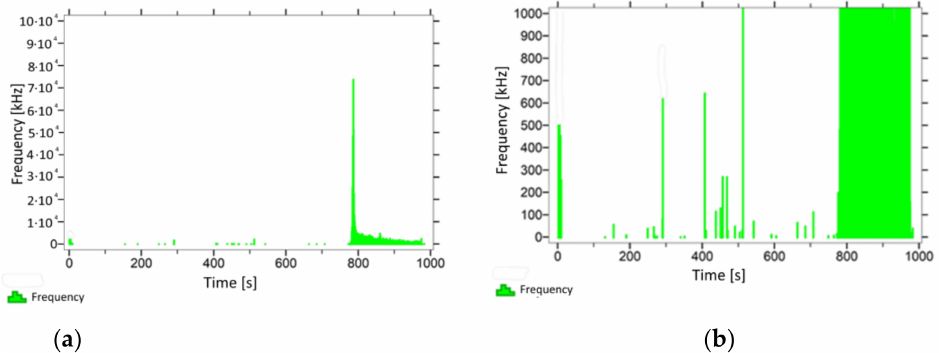
Figure 10. Graph of frequency distribution during the test for a representative sample from series P 9 : ( a ) considering the entire occurring frequency range and ( b ) with details about the frequency range before the moment of breakage.